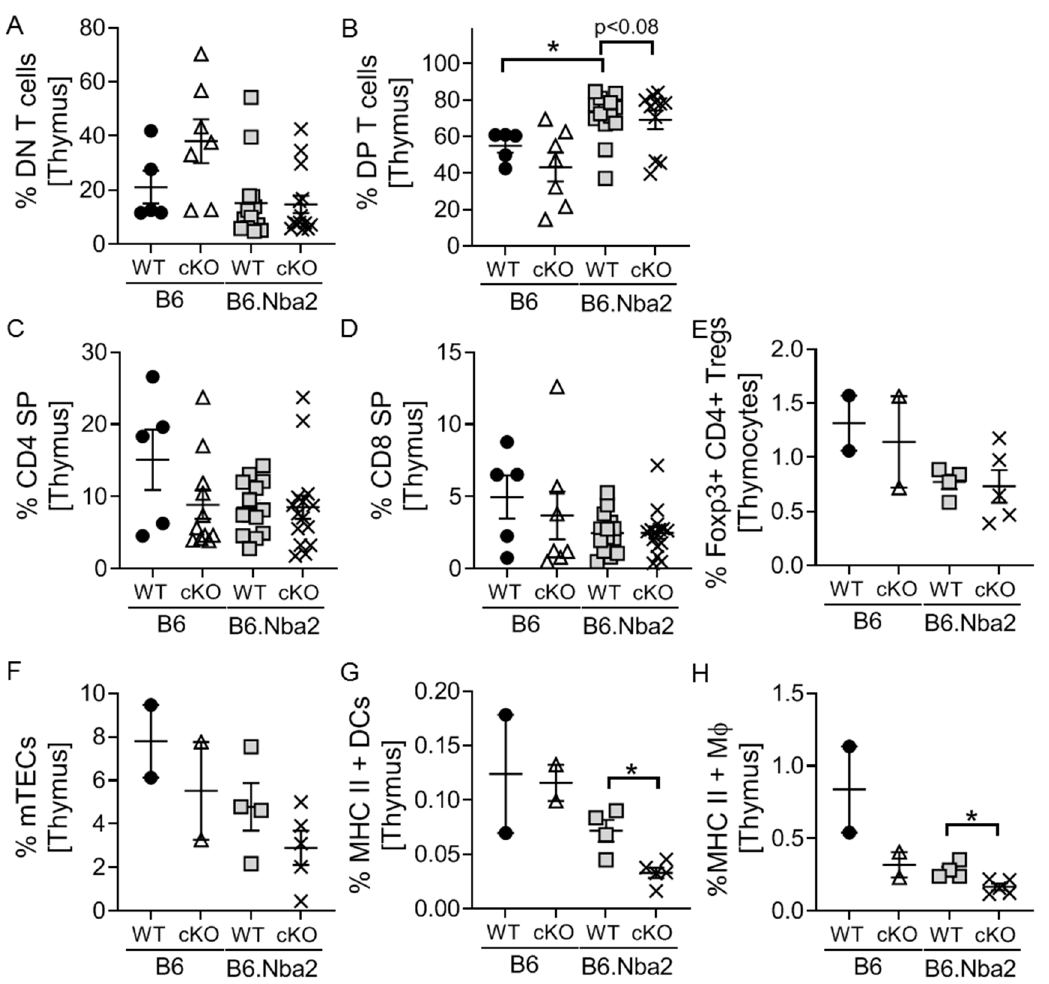
Figure 5. T-cell specific IFNAR deficiency partly reverses DP thymocyte accumulation and lowers levels of MHC-II-expressing thymic dendritic cells. IFNAR-sufficient and -deficient female B6 and B6.Nba2 mice were analyzed for splenic frequencies of DN ( A ), DP ( B ) and SP ( C , D ) thymocytes. n = 4 – 5 (B6), n = 11 (B6 cKO), n = 14 (B6.Nba2), n = 9 (B6.Nba2 cKO). A separate cohort of mice were further analyzed for thymic CD4+ Tregs ( E ), medullary thymic epithelial cells (mTECs)( F ), MHC class II+ thymic DCs ( G ) and MHC class II+ thymic macrophages ( H ). Each symbol represent one mouse. * p < 0.05, Student’s unpaired t -test with Welch’s correction. 2.6. Kidney-Infiltrating T Cells Are Unaffected by Intrinsic IFNAR Expression Finally, both CD4+ and CD8+ T cells have been shown to infiltrate kidneys of lupus patients. In particular, CD8+ T cells are believed to contribute to nephritis in SLE patients as levels associate strongly with both proteinuria and serum anti-dsDNA autoantibodies [45]. We stained kidneys from WT and cKO B6 and B6.Nba2 mice for CD4 and CD8 to visualize levels of infiltrating T cell populations (Figure 6). Both CD4+ and CD8+ T cells were periglomerular infiltration was observed predominantly in cKO mice of both